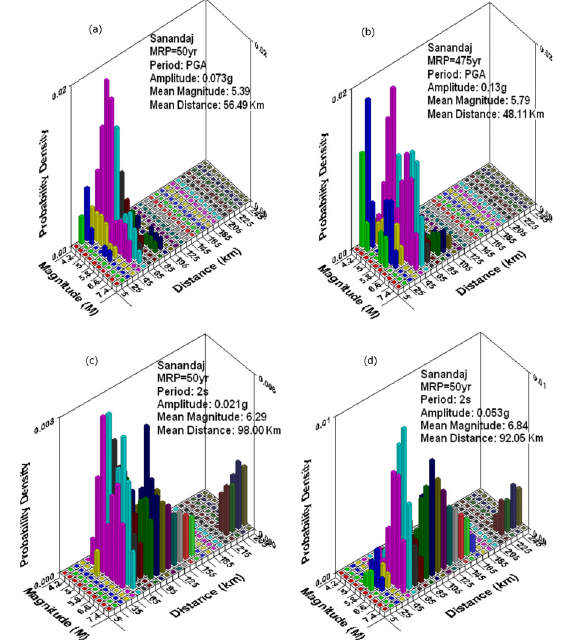
Figure 8. Disaggregated seismic hazard for a site in Sanandaj for 63% and 10% in 50 years probability of exceedances for PGA and Sa(0.2s). Bins of width 0.4 in magnitude, 10 km in distance, and 0.2 in ε are used.